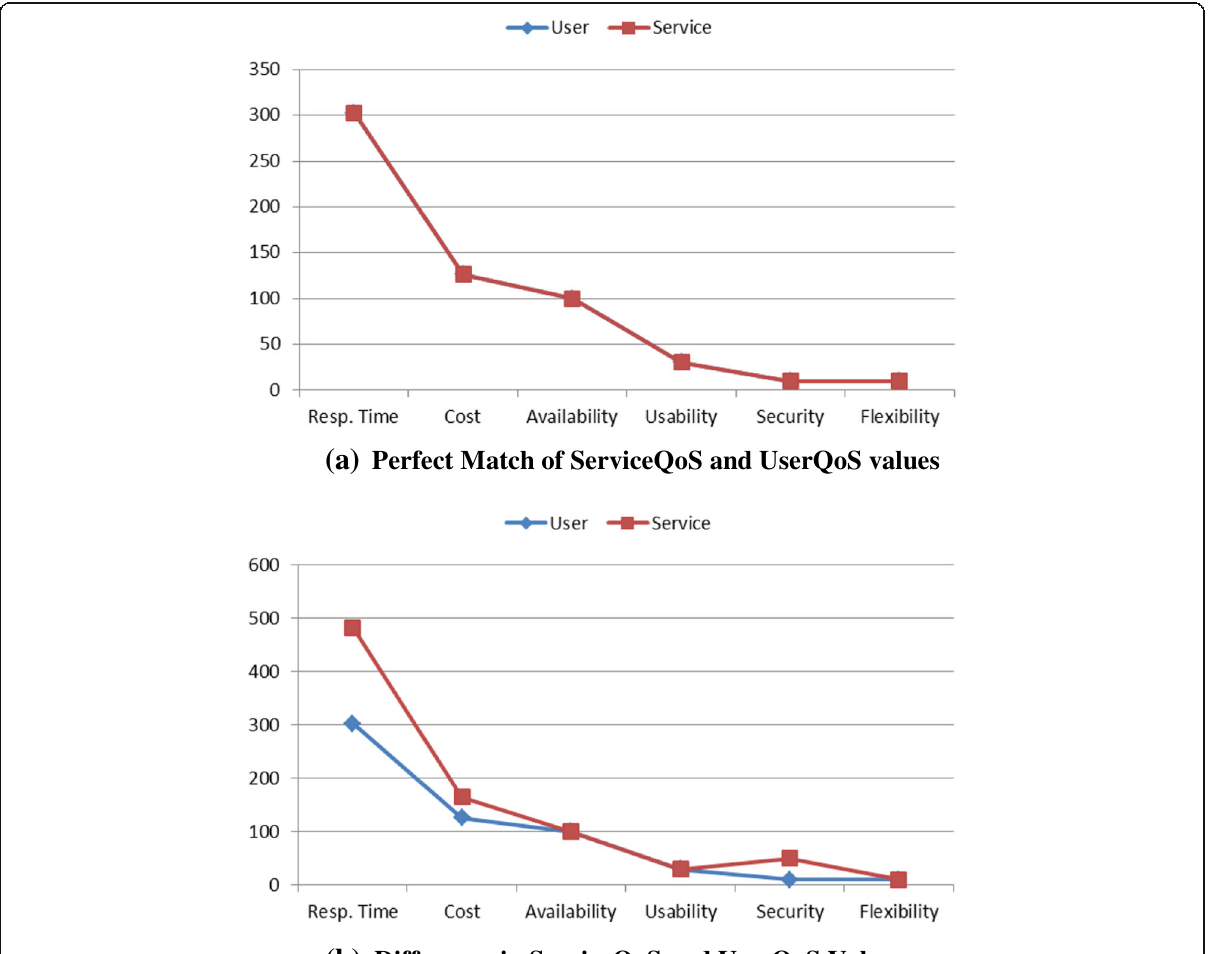
Fig. 1 Line Graph showing Cloud Service QoS Vs. User QoS Requirements. The line graph graphically depicts the similarity of the QoS properties of the cloud services and the QoS requirements of the users. Panel (a) shows that there is a perfect match between the User ’ s QoS requirement and the QoS properties of the cloud service; while Panel (b) shows a variance between the QoS properties of the cloud service and the QoS requirement of the user